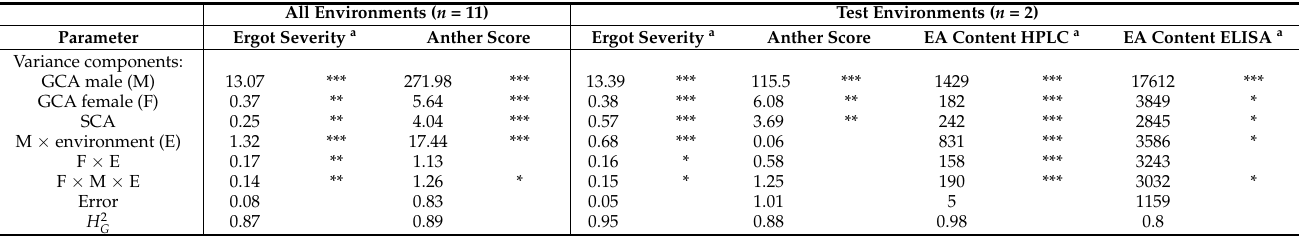
Table 2. Estimates of variance components for general (GCA) and specific combining ability (SCA) and genotypic entry- mean heritability ( H 2 ) of four female CMS lines and four male restorer lines for ergot severity, anther score (AS), and ergot G alkaloid (EA) contents analyzed by HPLC and ELISA across all environments ( n = 11) and the test environments ( n =